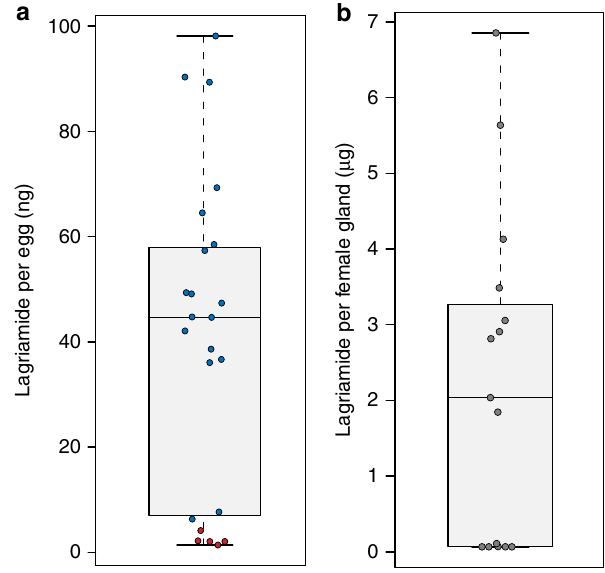
Fig. 3 Lagriamide is present in variable amounts on eggs, as well as in the female accessory glands of Lagria villosa females. a Lagriamide amount per egg determined for crude extracts from 22 independent clutches laid by fi eld-collected L. villosa females. Circle color indicates the presence (blue) or absence (red) of B. gladioli Lv-StB as assessed using qPCR. b Lagriamide amount determined for crude extracts from single accessory glands of 15 fi eld-collected L. villosa females. The center value of the boxplot